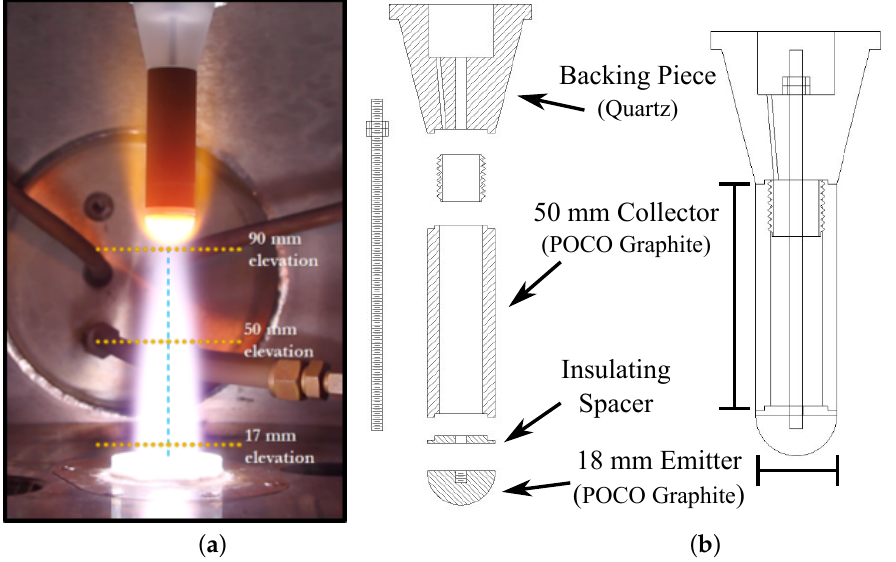
Figure 2. ( a ) Experimental setup showing axial locations relevant to the CFD simulations performed in the current work. Figure from [19]. ( b ) Schematic of the test article design. Not shown is a water-cooled fixture to which the backing piece is